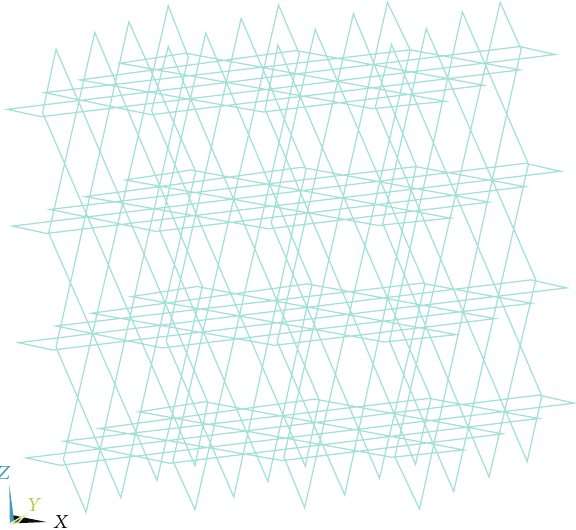
Figure 18: Octahedron model: displacement taken about the 𝑧